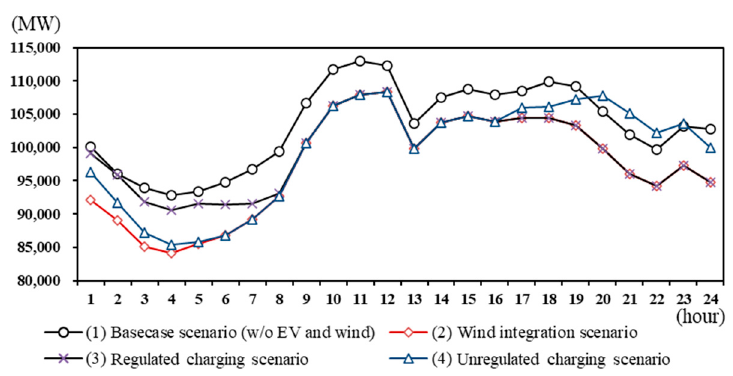
Figure 3. System net-load profiles of each scenario.